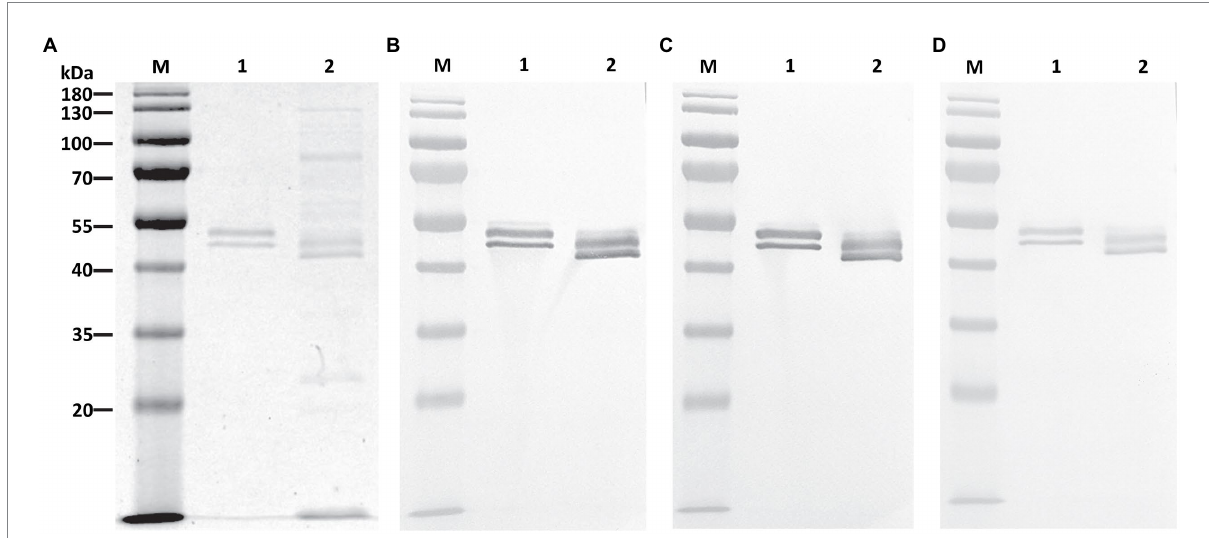
FIGURE 6 Plant-Made 4H2 Isotypes Bind to Target Antigen on Western Blot. Recombinant CTS1 and Coccidioides posadasii mycelial culture supernatant were separated by SDS-PAGE (12%) under reducing conditions and either stained with Coomassie Blue (A) or transferred to PVDF membrane. Membranes were then probed with the parental M-4H2 IgG (B) , the humanized, P-4H2 IgG (C) , or the humanized, P-4H2 IgM (D) , followed by the appropriate secondary HRP-conjugated antibody and development with a colorimetric substrate. Lane 1, Recombinant CTS1. Lane 2, Coccidioides posadasii mycelial culture supernatant. M, molecular weight